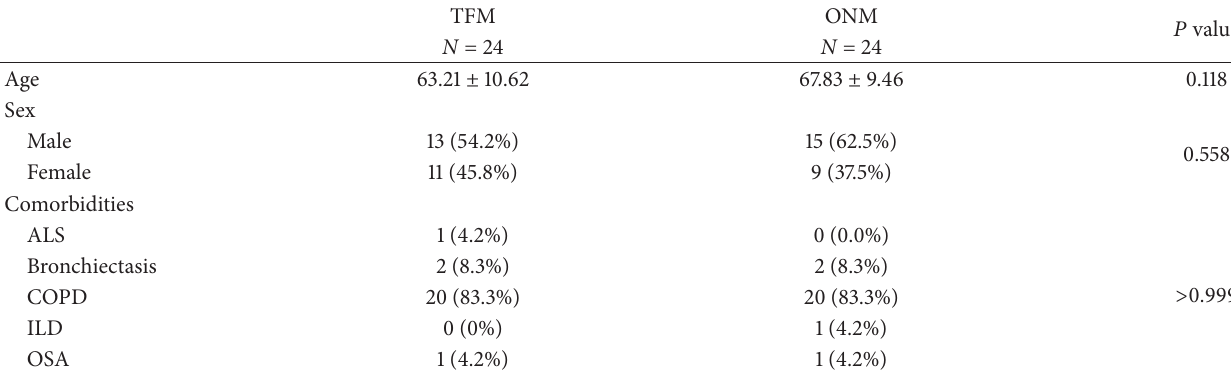
Table 1: Age, gender, and comorbidities in patients in the two groups.